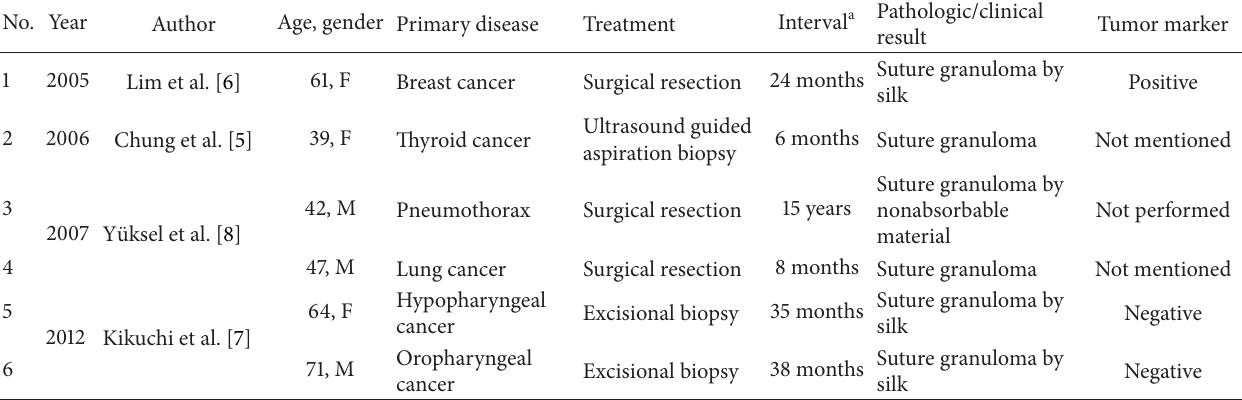
Table 1: Previous case reports of suture granulomas showing false-positive findings on FDG-PET after surgery.